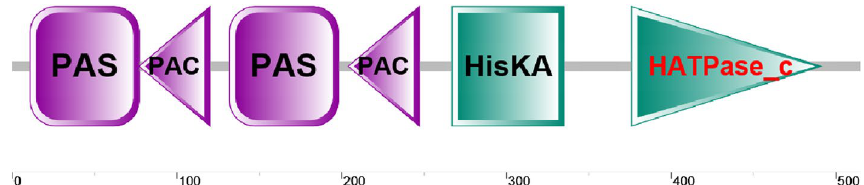
Fig. 2 Domain structure of RegO generated by SMART (http:// smart. ambl‑ heide lberg. de/ ). Multi‑domain hybrid structure of RegO in Rsp. rubrum . RegO possesses two PAS domains, a histidine kinase (HisKA) domain and HATPase domain